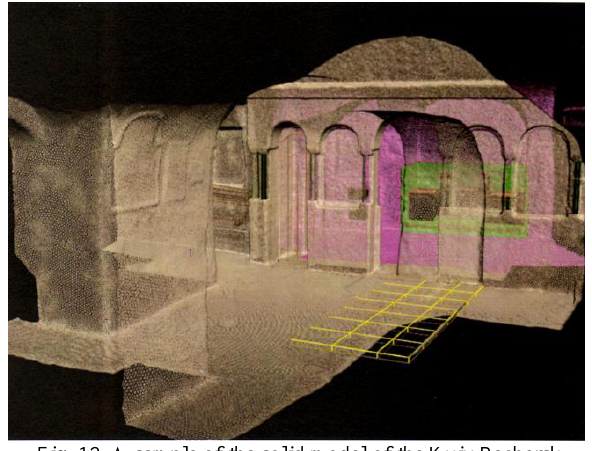
Fig. 12. A sample of the solid model of the Kyiv Pechersk Lavra caves